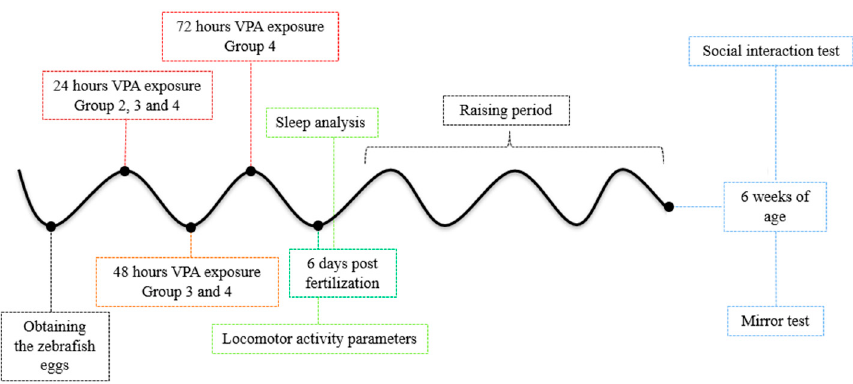
Figure 1. Schematic diagram of VPA exposure in zebrafish embryos. VPA administration started in the first hours post-fertilization and ended after 24 h for Group 2, 48 h for Group 3 and 72 h for Group 4. Time of evaluation and behavioral tests are mentioned.